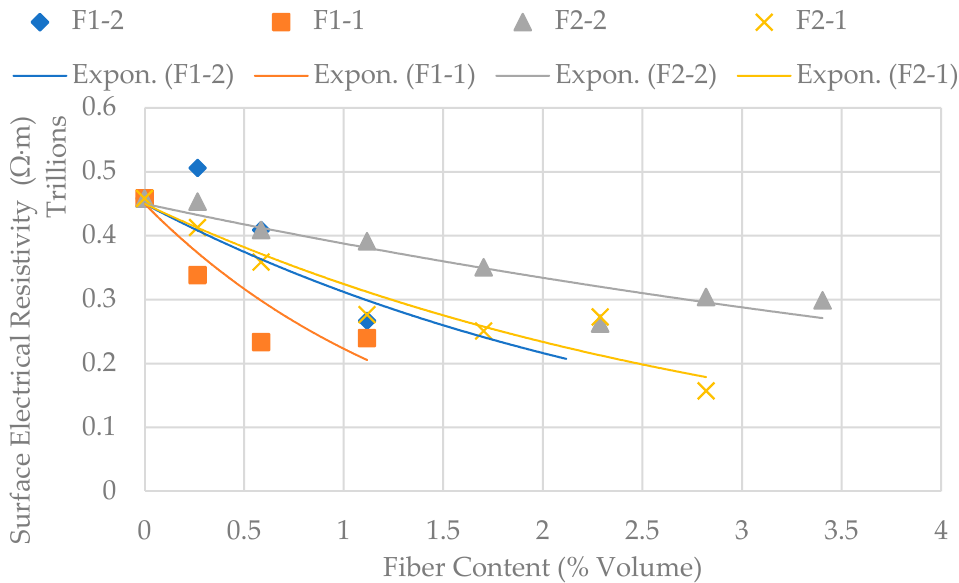
Figure 6. The electrical resistance for different percentages of fiber content. Table 3. Regression results for surface electrical resistivity.